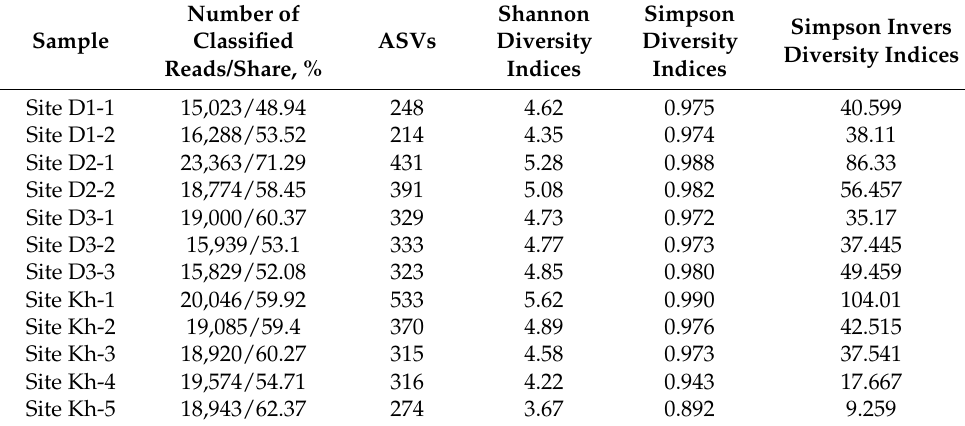
Table 3. Soil microbial community